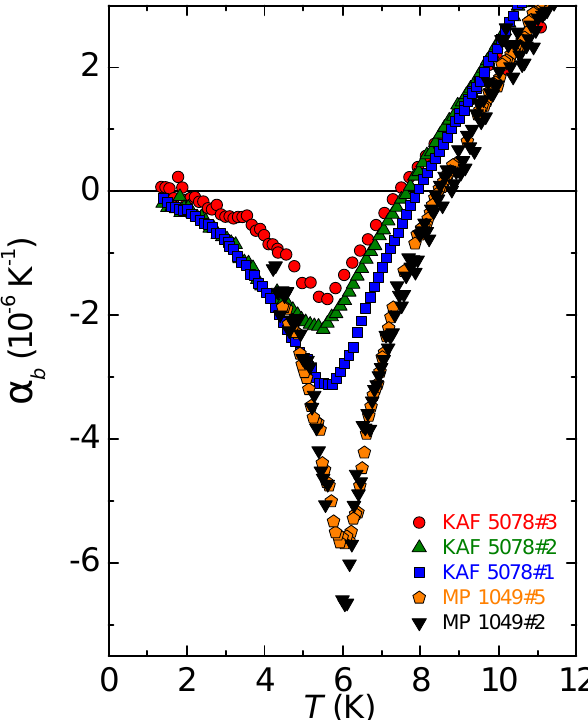
Figure 3. Comparison of the in-plane b -axis thermal expansion coefficient of κ -(BEDT-TTF) 2 Cu 2 (CN) 3 for a selection of 5 out of 9 single crystals taken from two different